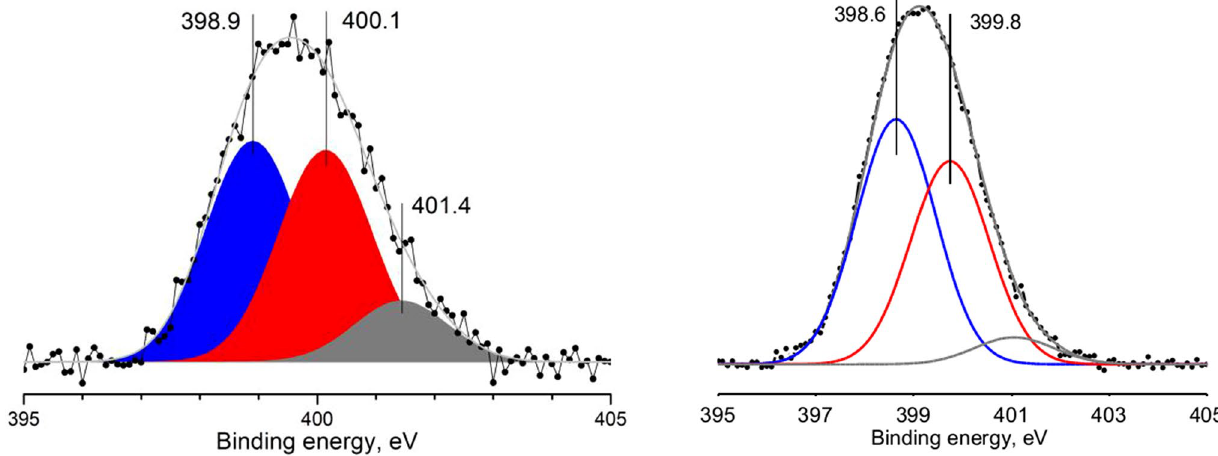
Fig. 2 XPS spectra of the N1s line with inelastically scattered electrons background subtracted using the Shirley model and deconvolution using the pseudo-Voigt function deconvolution for samples CNT-M (left) and CNT-MF